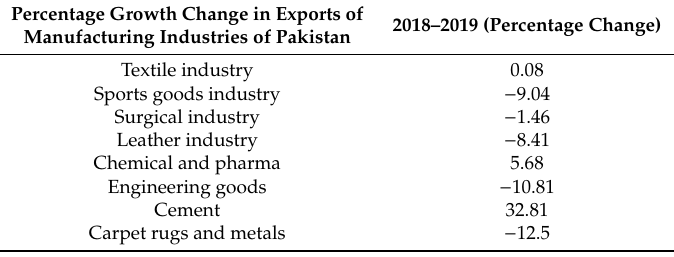
Table 1. Manufacturing industries’ growth in exports of